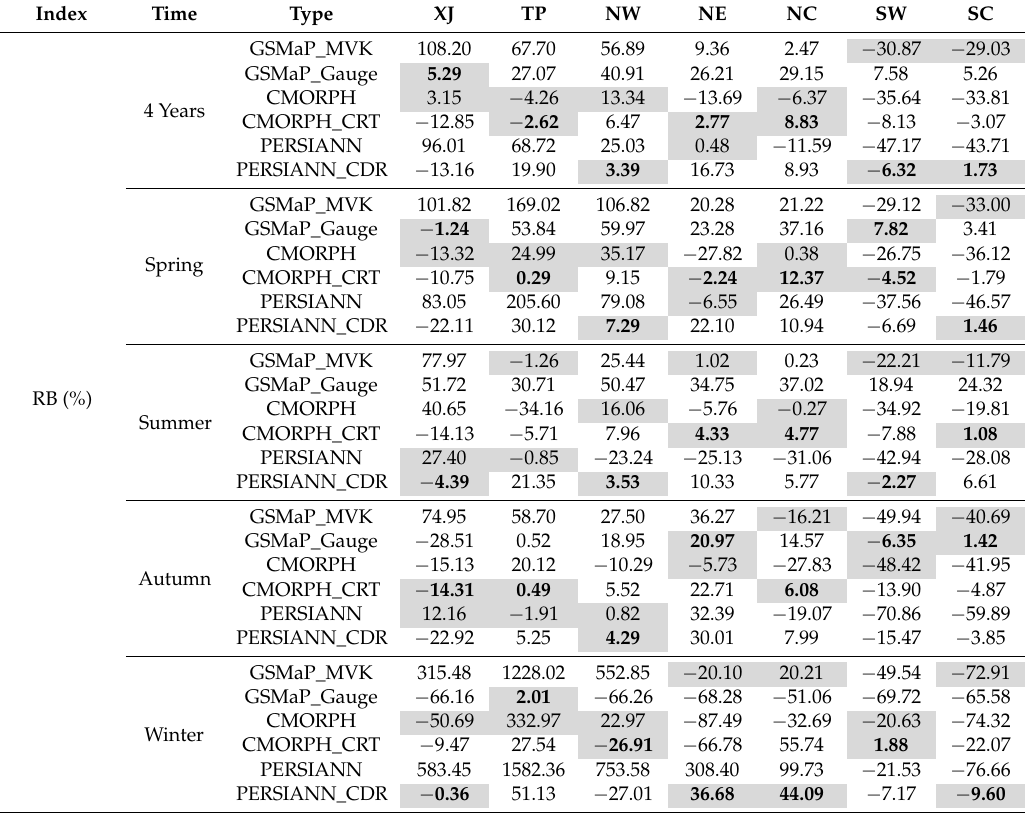
Table A1. RB, RMSE, and CC between CPAP and the selected satellite-based products for Annual and Seasonal Precipitation in seven sub-regions (XJ, TP, NW, NE, NC, SW and SC). The best satellite-only product in each season over different sub-regions is highlighted with regular font in gray background and the best gauge-corrected product is highlighted with bold font in gray